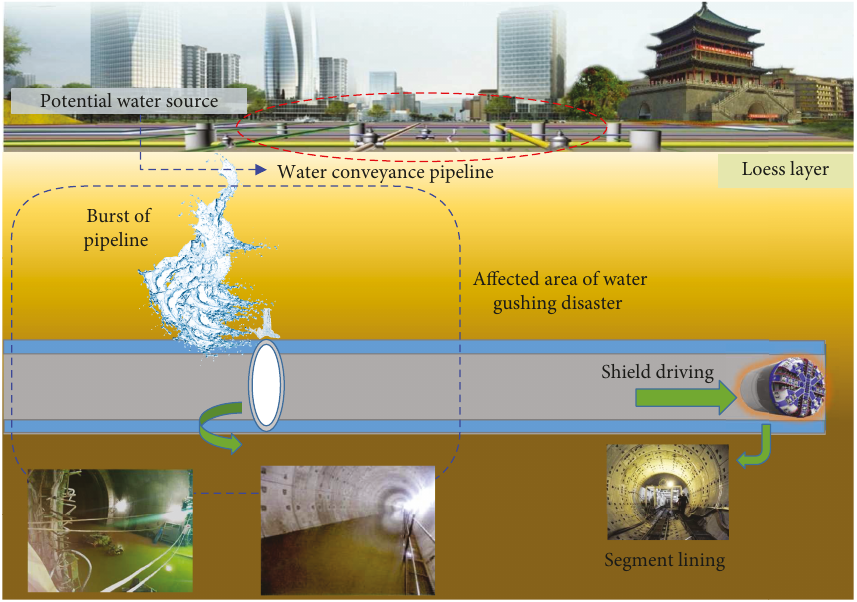
Figure 1: Sketch map of water gushing at